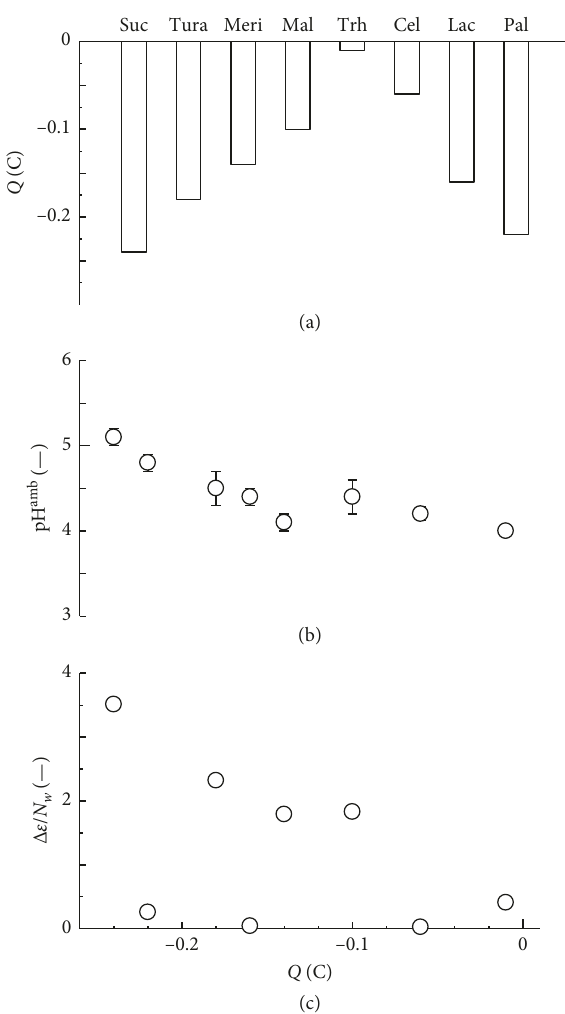
Figure 7: (a) Electronic charge around oxygen in the glycoside bond of disaccharides. Q dependency of (b) pH amb and (c) Δ ε / N w . Suc: sucrose; Tura: turanose; Meri: meribiose; Mal: maltose; Trh: trehalose; Cel: cellobiose; Lac: lactose; Pal: